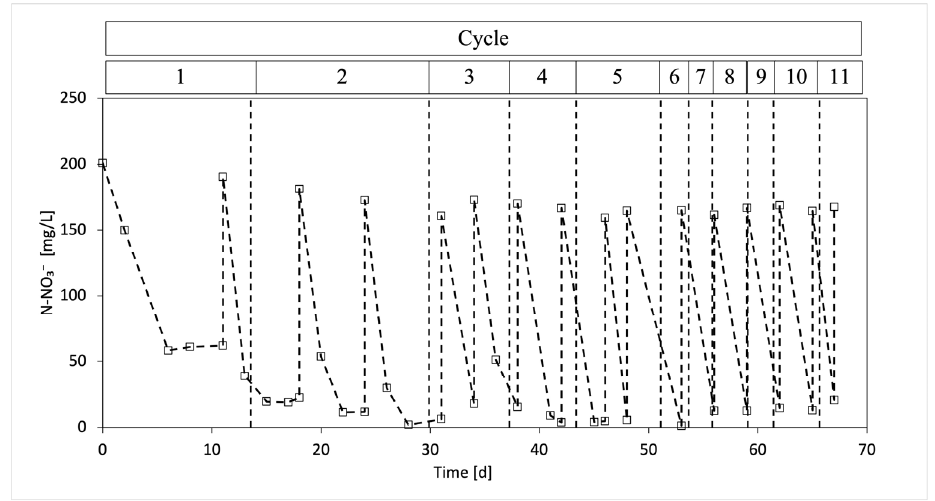
Figure 2. Variation of the concentration of N-NO 3 − over time during the enrichment of the denitrifying inoculum.